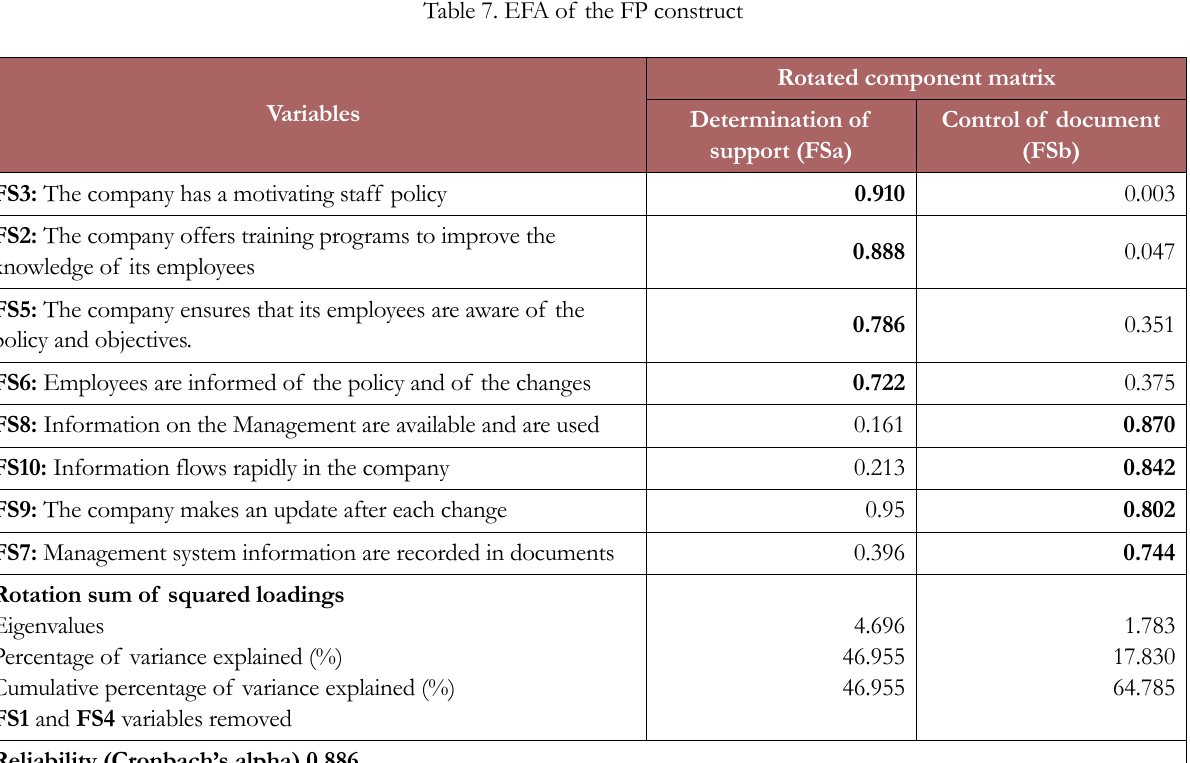
Table 7. EFA of the FP construct